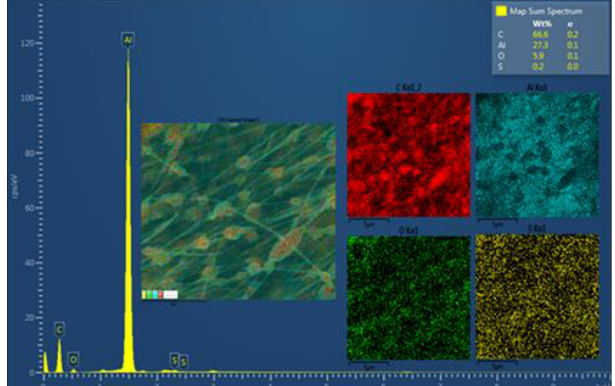
Figure 6. SEM-EDS of aligned EM4. The elements of carbon (C), aluminum (Al), oxygen (O), and sulfur (S) are designated with the colors red, light blue, green, and yellow, respectively.